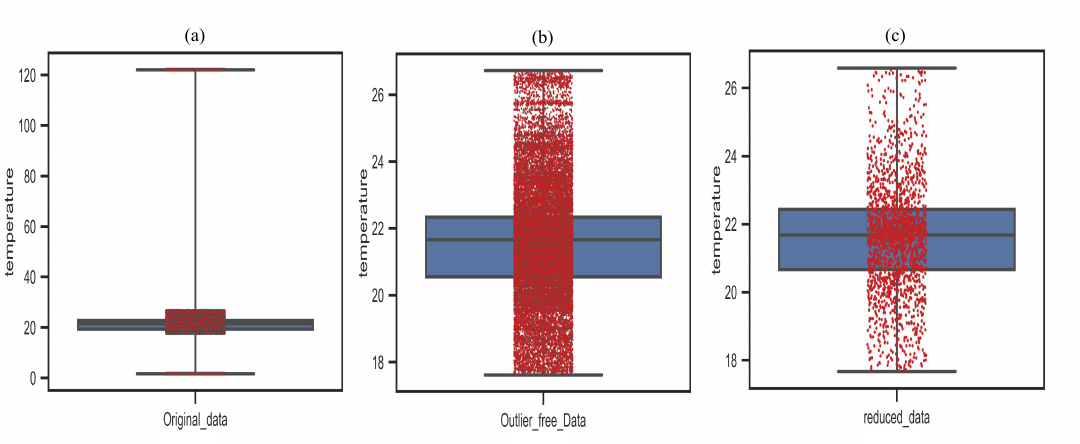
Figure 20. A comparison among original data, outlier-free data by the proposed EDC and the reduced data by the EDC technique versus temperature. ( a ) Original data (1 × 28,800); ( b ) outlier-free data (1 × 28,800) with the V-RODS algorithm; ( c ) reduced data (1 × 1920) with the EDC